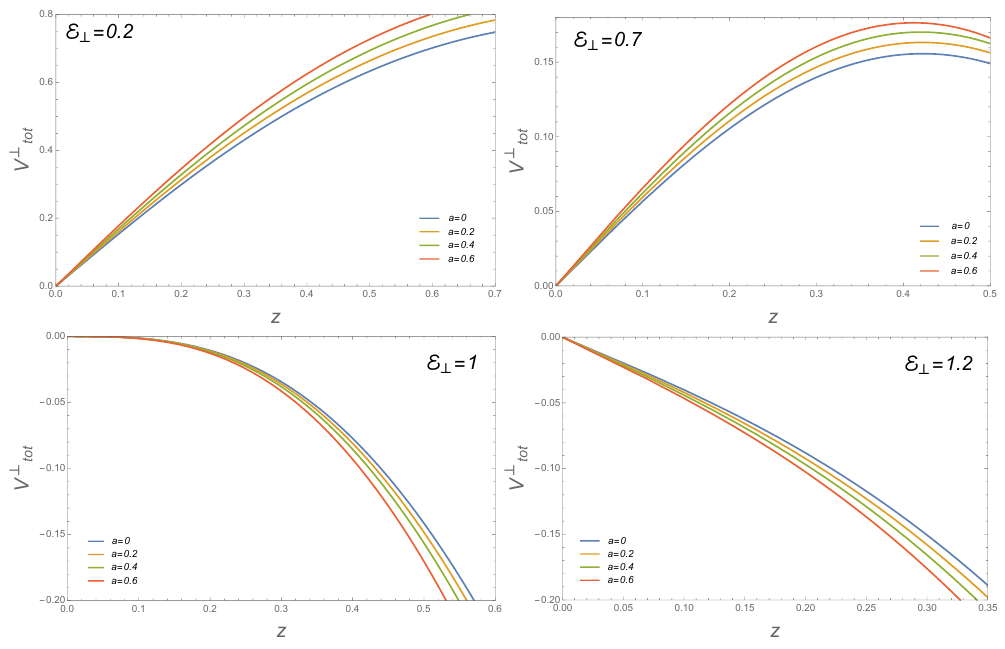
Figure 5 . The holographic potential V ⊥ fixed E ⊥ in the black brane